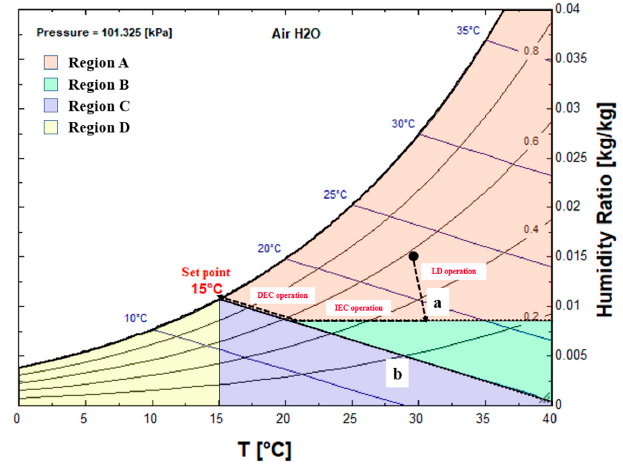
Figure 2. The operating modes for LD-IDECOAS depicted on a psychrometric chart.